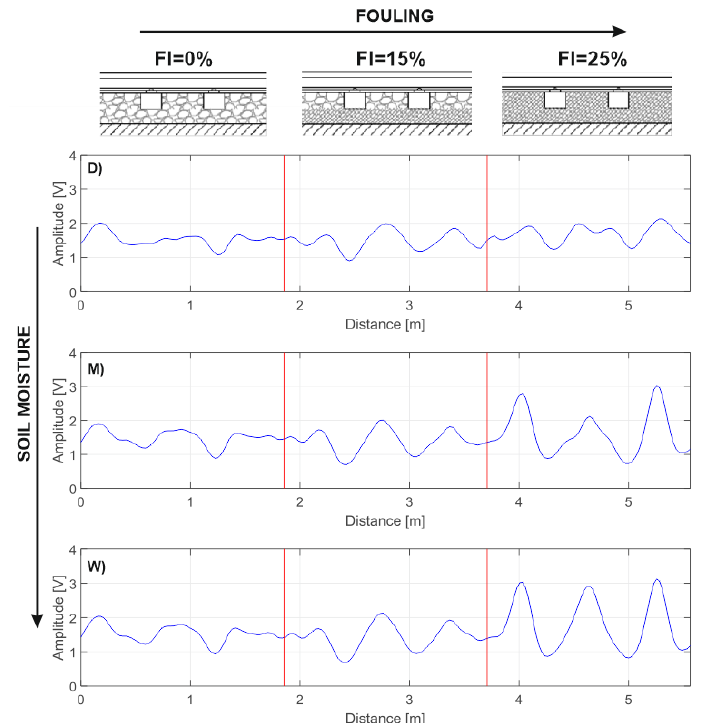
Figure 10. Amplitude of the air-surface reflection for clean (FI = 0%), partially-fouled (FI = 15%) and totally-fouled (FI = 25%) configurations, in dry (D), moist (M) and wet (W) conditions. Data were collected with a 90° orientation of the 1000 MHz antenna system.